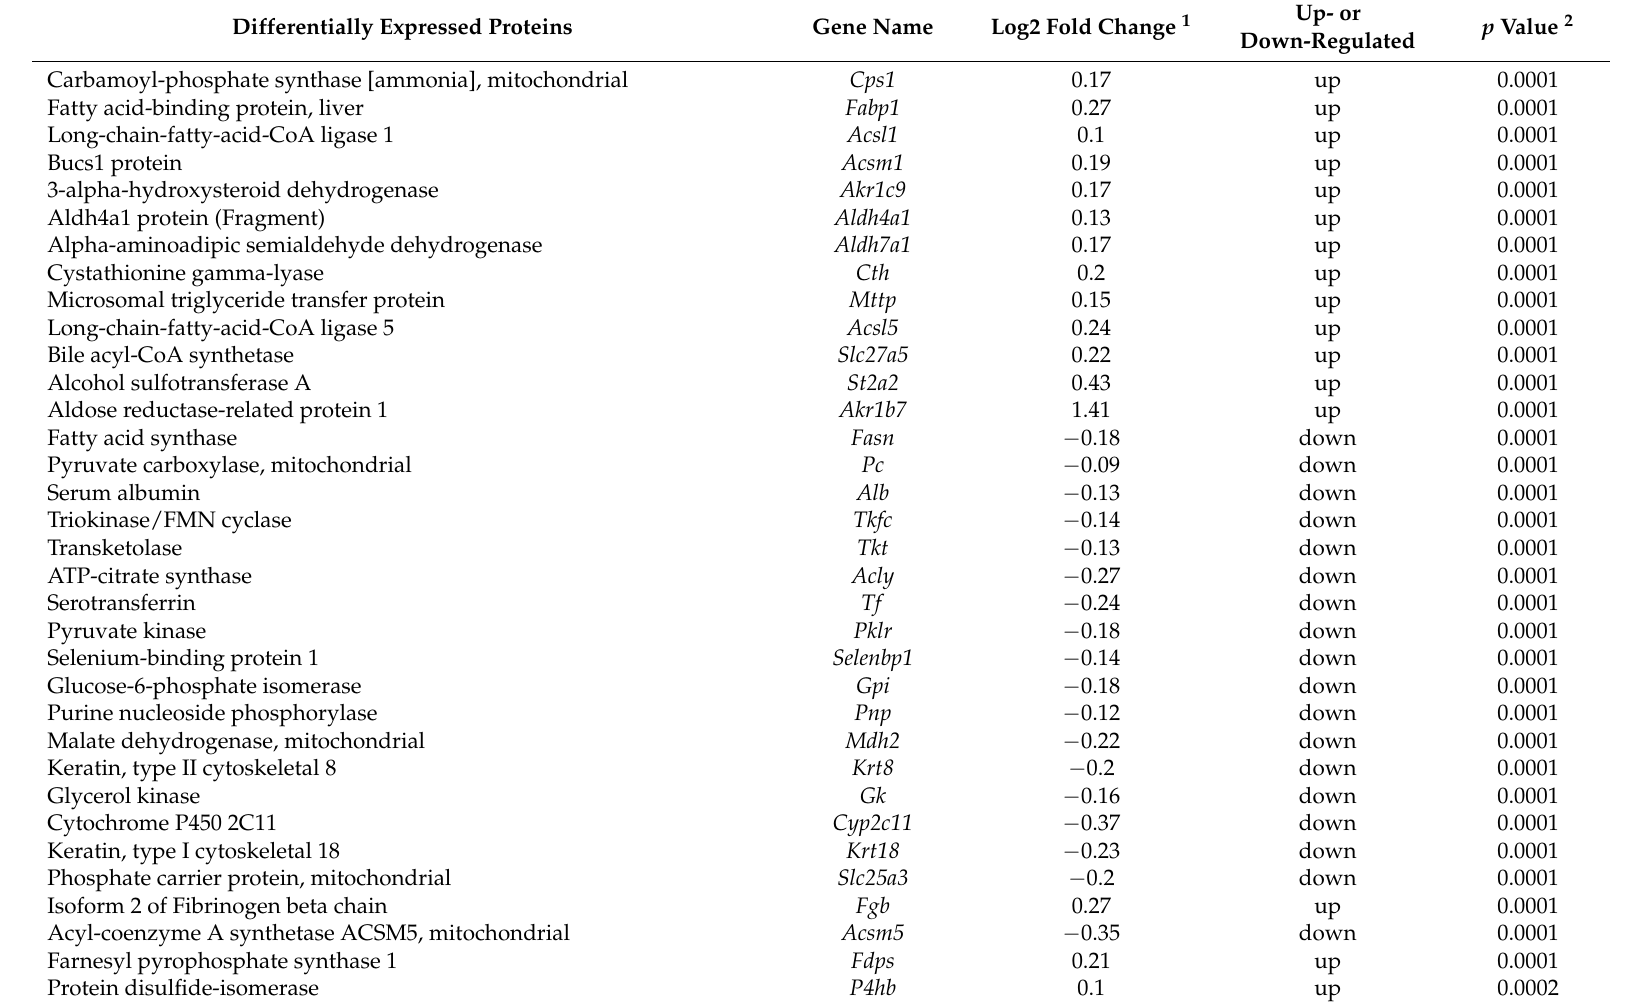
Table 6. Differentially expressed proteins with Purple Potatoes diet in